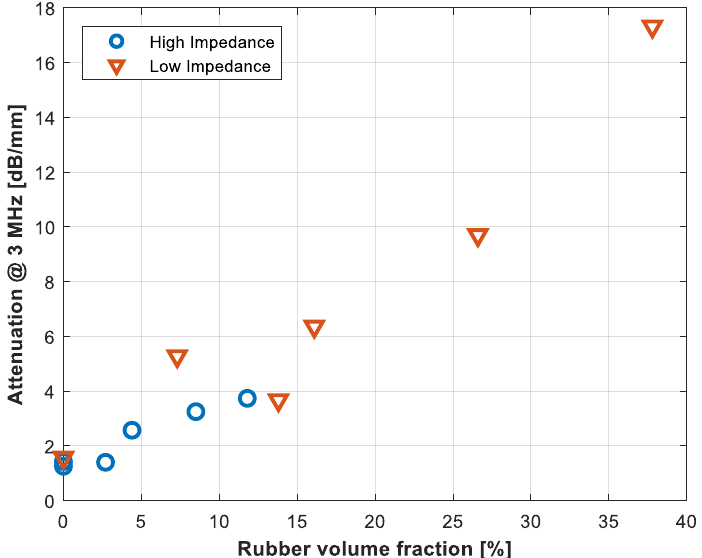
Figure 9. Ultrasonic attenuation coefficient at 3 MHz vs. rubber volume fraction. Results for both the high and the low impedance series. Table 11. Measured ultrasonic properties of the tungsten-loaded epoxy composites.